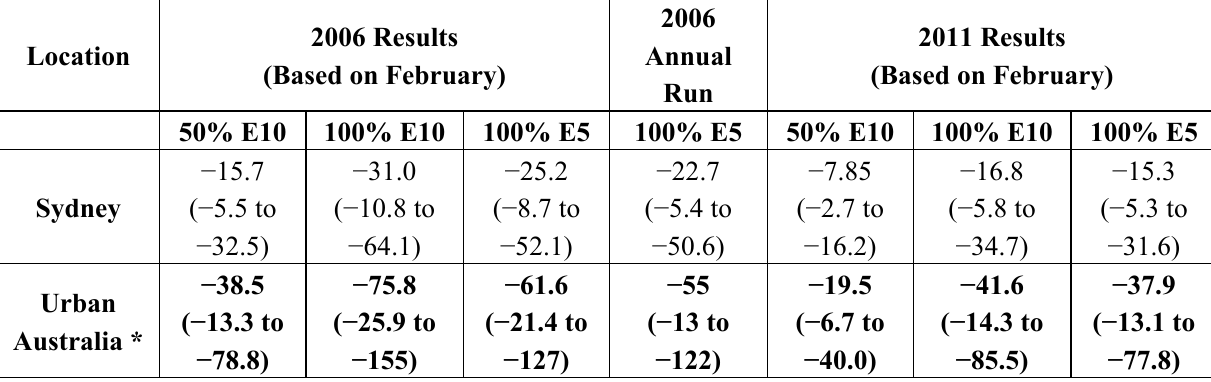
Table 1. Total Quantified Annual Health Impact changes of Ethanol over ULP for PM Mortality and Morbidity (2007A$millions, 90% CI) based on monthly and annual simulations.